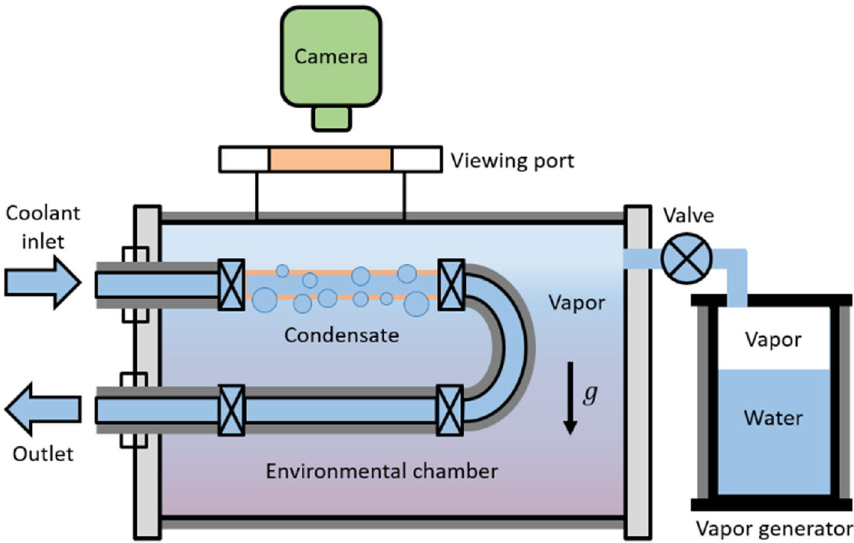
Figure 4. Schematic of the experimental setup constructed for phase change condensation study. The environmental chamber maintains saturation condition by eliminating NCGs from the system. The vapor that enters the chamber condenses on the copper tube that is maintained below the saturation temperature by circulating chilled water from a water bath heat exchanger. To minimize heat loss to the surrounding environment, both the chamber and the vapor generator are insulated using a fiberglass sheet. The chamber has a view port to observe droplet nucleation, growth, and